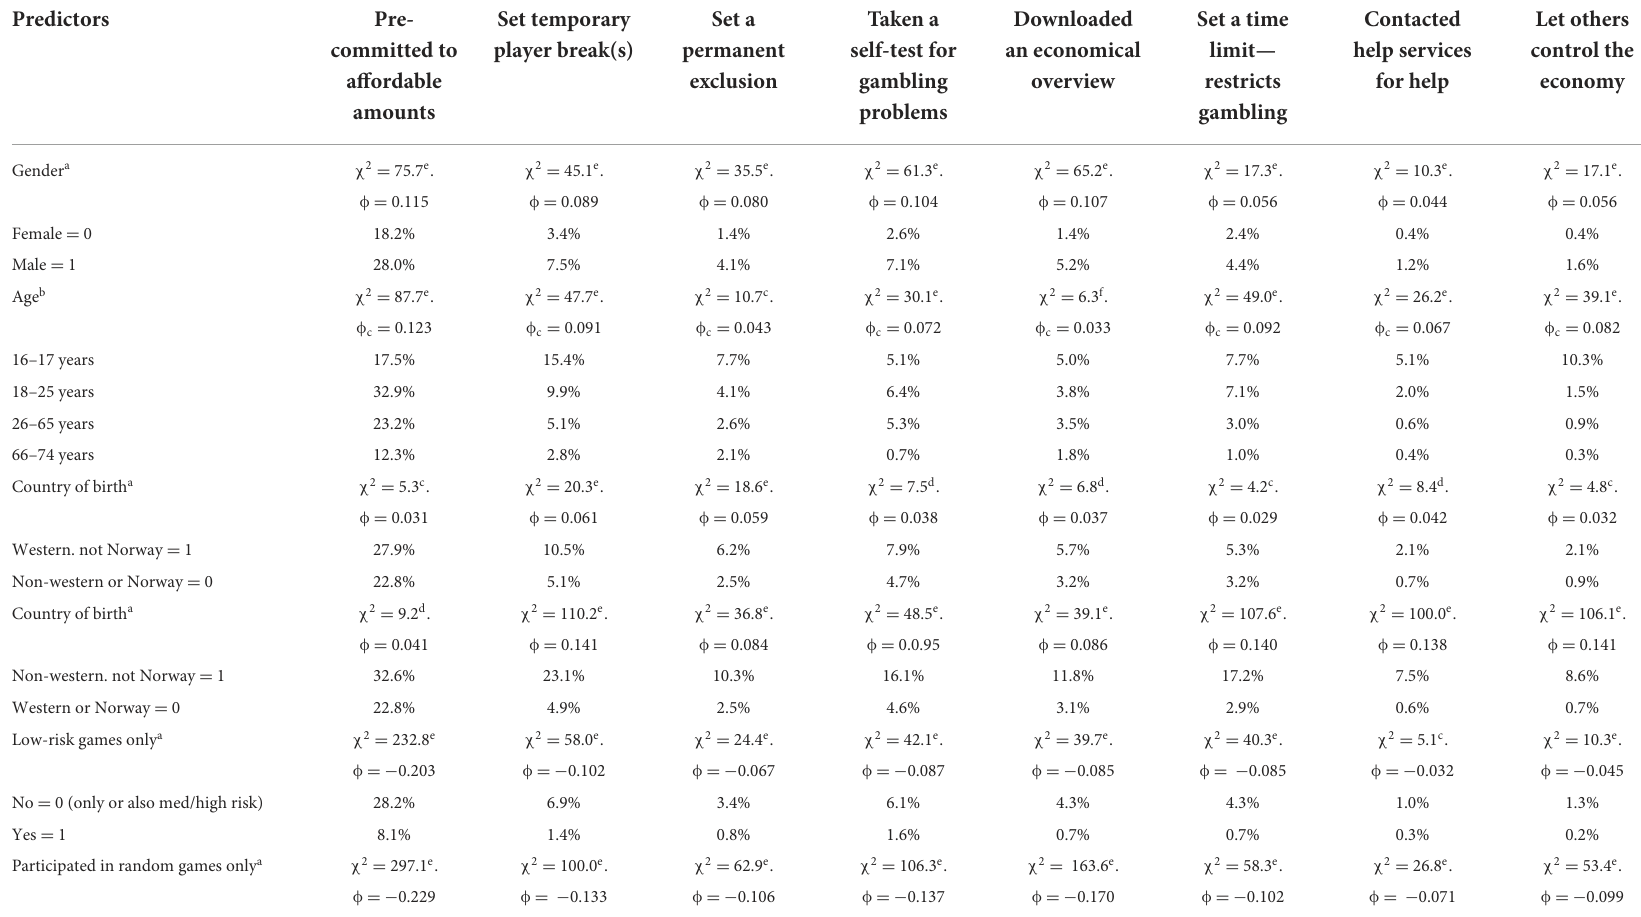
TABLE 5 Gamblers who use the measures to prevent gambling problems. Percentage, chi-square ( χ 2) and phi ( φ ) and Cramer’s V( φ c ) (N